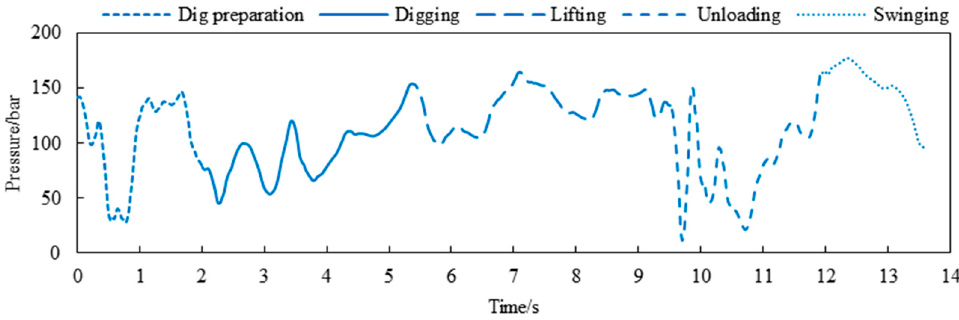
Figure 17. Reconstruction results of trend terms of typical load.